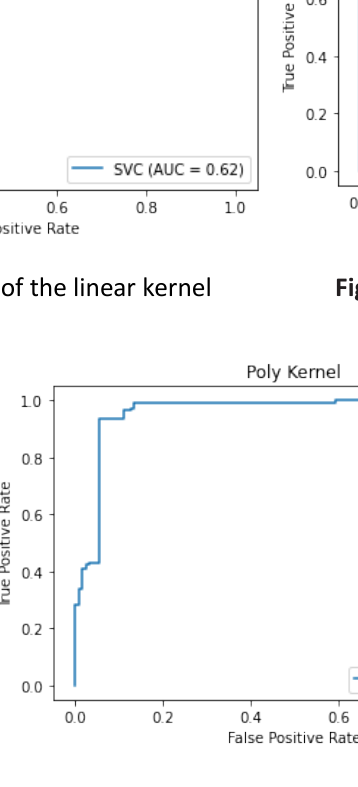
Figure B4. ROC curve of the Poly